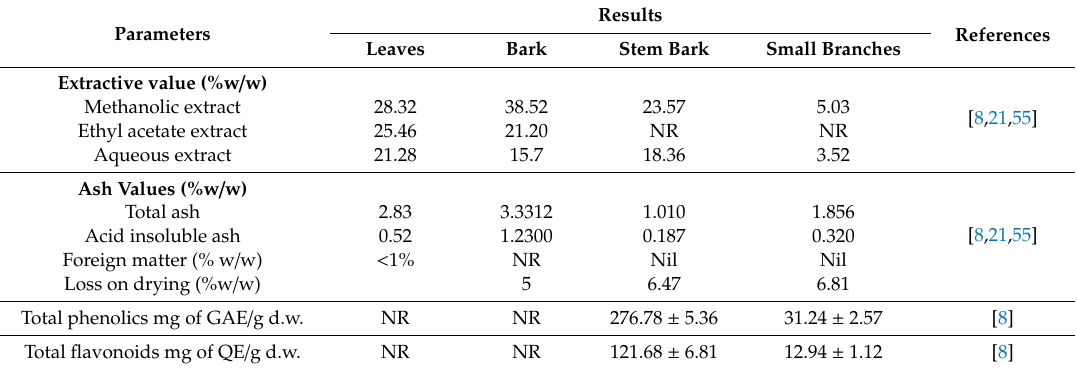
Table 3. Physiochemical parameters of di ff erent parts of M.